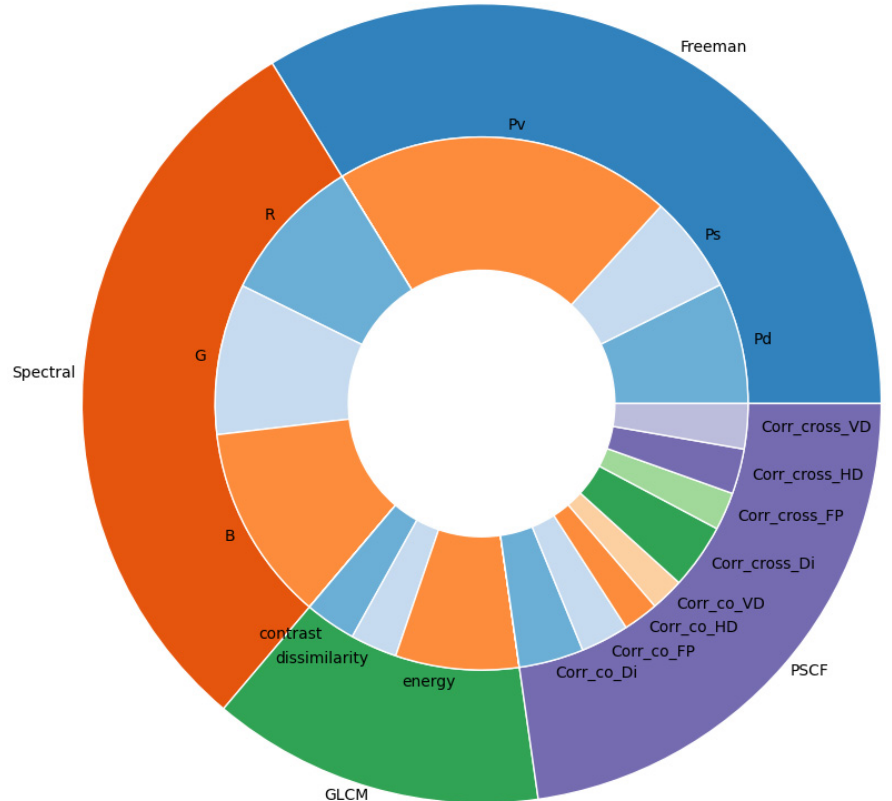
Table 5. Feature importance of each feature.